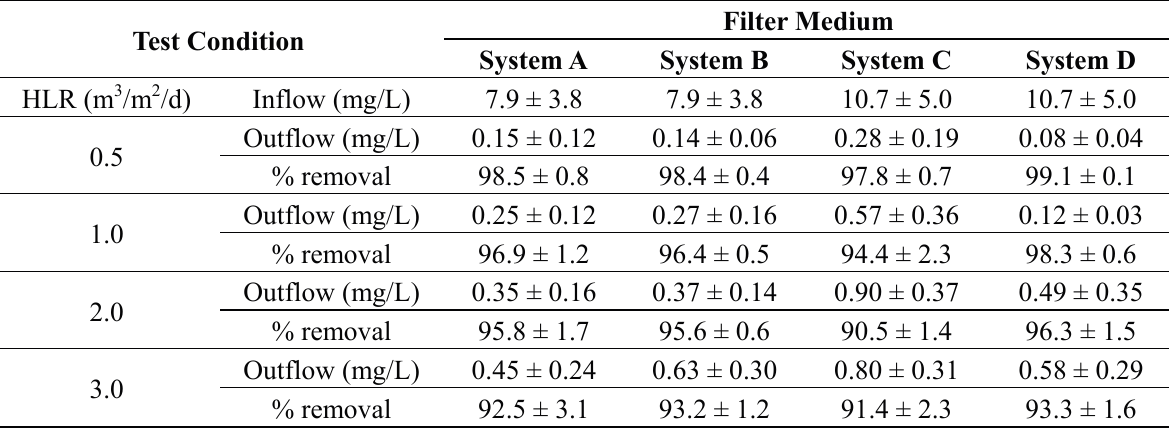
Figure 10. Average TP removal efficiency of the four MSL samples under various HLR conditions. Table 5. TP removal performance under different HLR